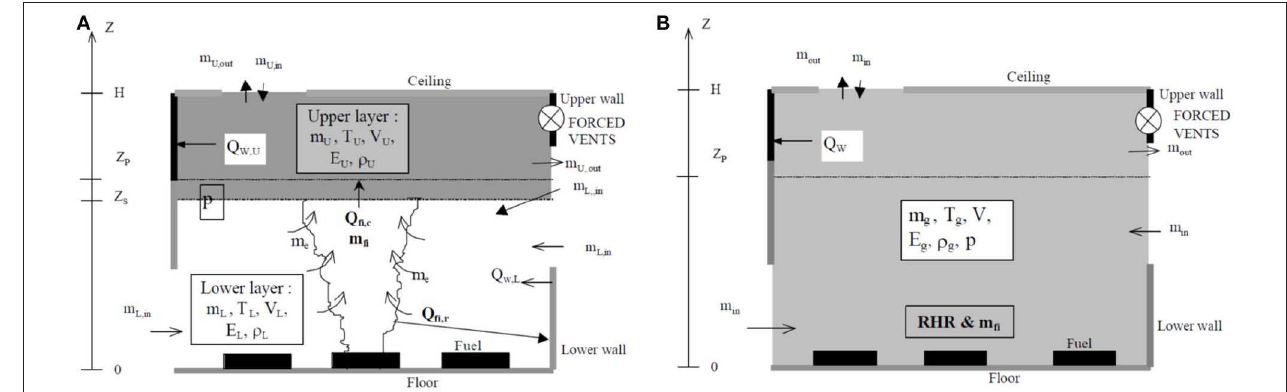
FIGURE 9 | Schematic view of two (A) and one (B) zone model and associated